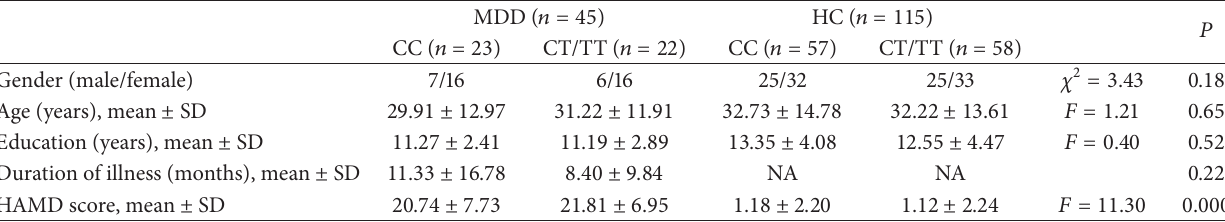
Table 1: Demographics and clinical data of participants.